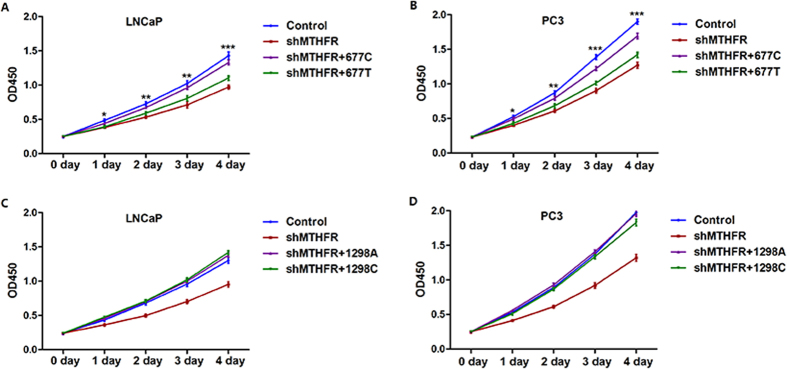
MTHFR c.677T variant inhibits cell proliferation.(A) c.677T variant of MTHFR inhibits cell proliferation significantly compared with wild-type MTHFR in LNCaP cells. (B) c.677T variant of MTHFR inhibits cell proliferation significantly compared with wild-type MTHFR in PC3 cells. (C) c.1298C variant of MTHFR has no significant effect on cell proliferation compared with wild-type MTHFR in LNCaP cells. (D) c.1298C variant of MTHFR has no significant effect on cell proliferation compared with wild-type MTHFR in PC3 cells. *Indicates P < 0.05, **indicates P < 0.01, ***indicates P < 0.001, all comparisons were performed between groups of shMTHFR + wild-type MTHFR and shMTHFR + c.677T/c.1298C MTHFR.